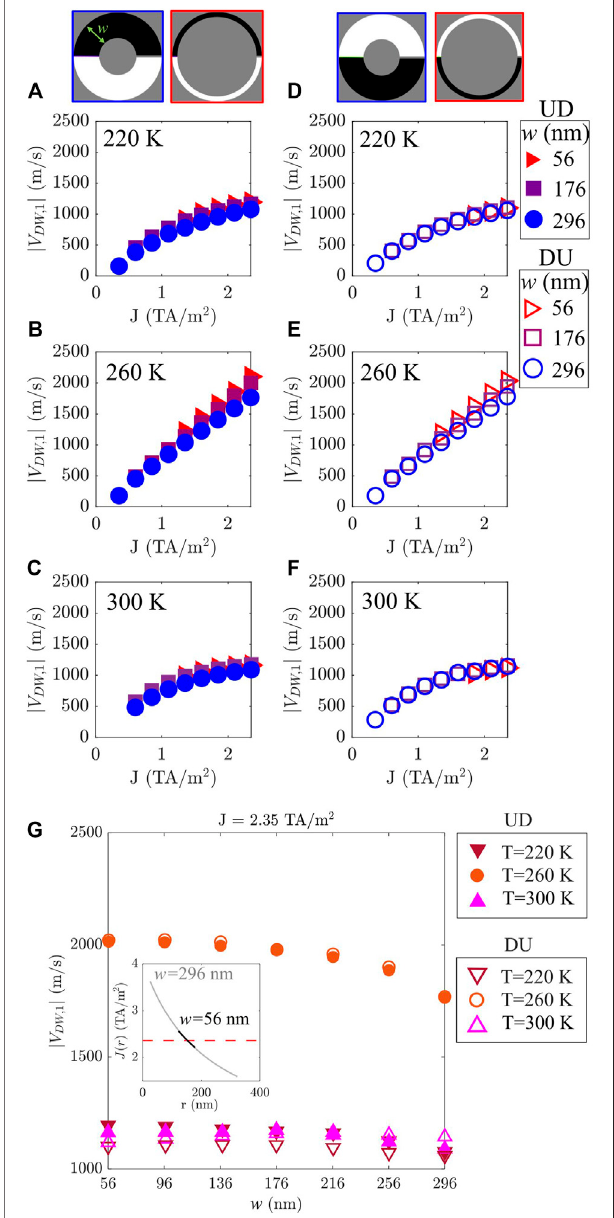
FIGURE3| TerminalvelocitiesasafunctionofJforaUD (A – C) andaDU (D – F) DW obtained for sub-lattice i (cid:2) 1 and for three different temperatures: below, above and at the AMC temperature (220, 300, and 260 K, respectively). Strips for the two limiting cases are shown in the red and blue contour insets at the top. (G) Terminal velocities as a function of w for a UD (full symbols) and a DU (open symbols) type wall for J (cid:2) 2.35 TA/m 2 and thethreechosentemperatures.Insetin (G) shows J ( r )fortwovaluesof w .Red dashed line indicates J (cid:2) 2.35 TA/m 2